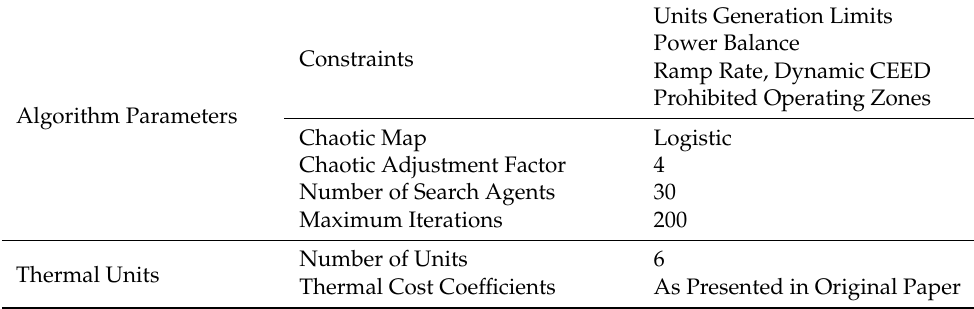
Table 13. Algorithm parameters, constraints, and renewable data—case study